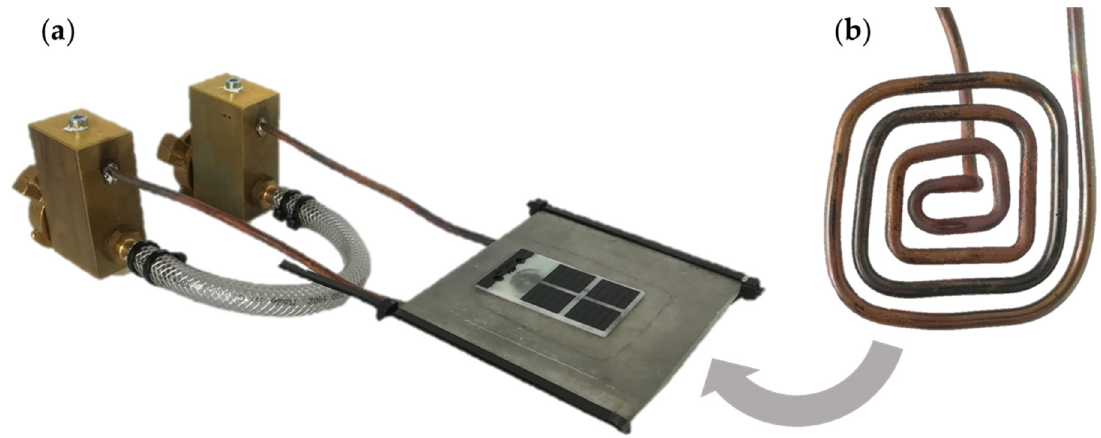
Figure 1. Testing equipment for inductive heating: ( a ) Test setup consisting of a test specimen on an insulation board with the inductor placed below; hookup system for electricity and coolant (water); ( b ) Pancake inductor fabricated from 8 mm copper tubing.